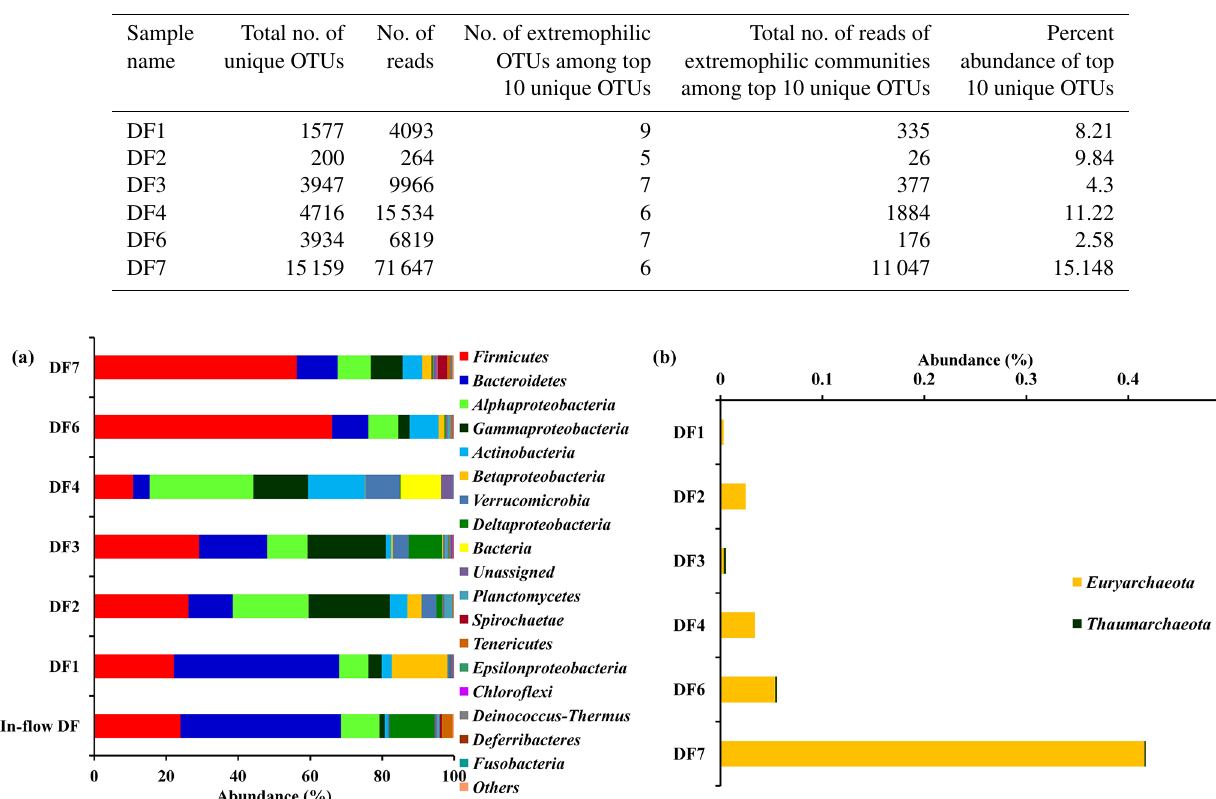
Figure 4. (a) Bacterial community composition of DF samples (original and returned DF samples) at phylum level (phylum Proteobacteria has been further divided into its different classes). Phyla which had minimum 1% abundance in the DF samples were selected and the remaining ones were grouped into “Others”. (b) Abundance of archaeal communities in DFs (phylum level).